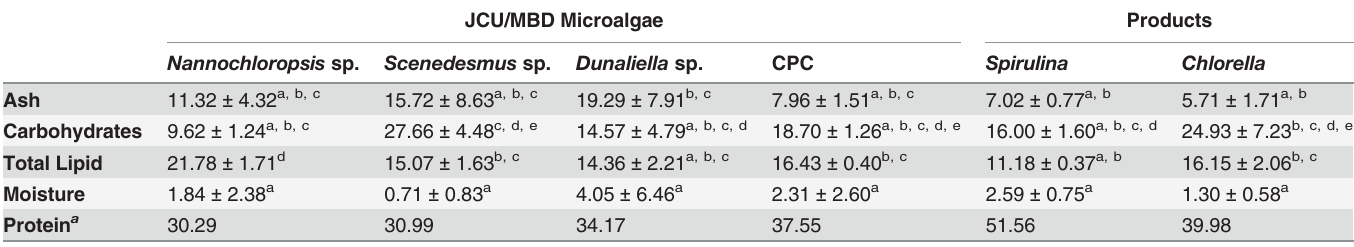
Table 4. Mean (% of dry weight) proximate biochemical composition of James Cook University/MBD Energy (JCU/MBD) microalgae and commercial microalgae products (mean ± SD, n = 3).